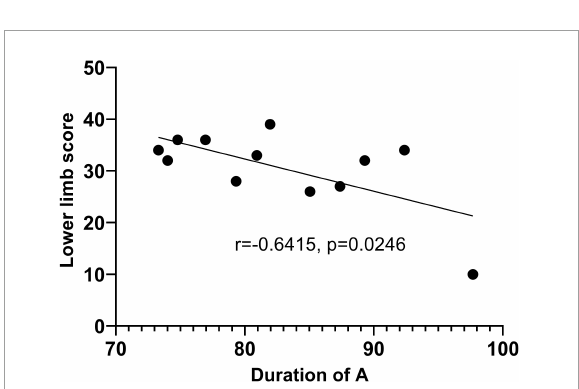
FIGURE6 Linear regression graph between duration of microstate A and lower limb